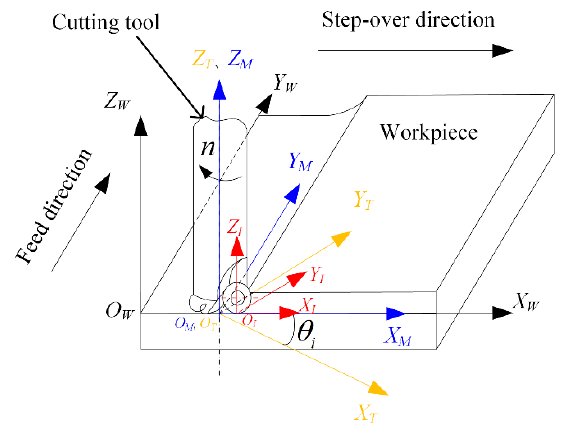
Figure 1. The machining coordinate systems used for the model.